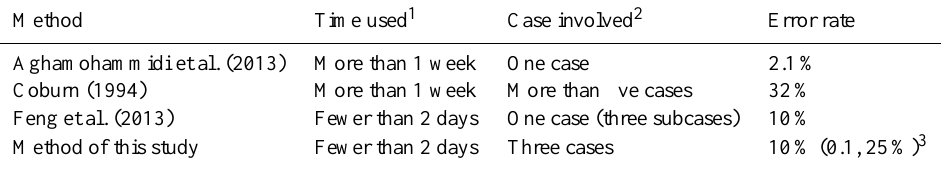
Table 3. Comparison of different